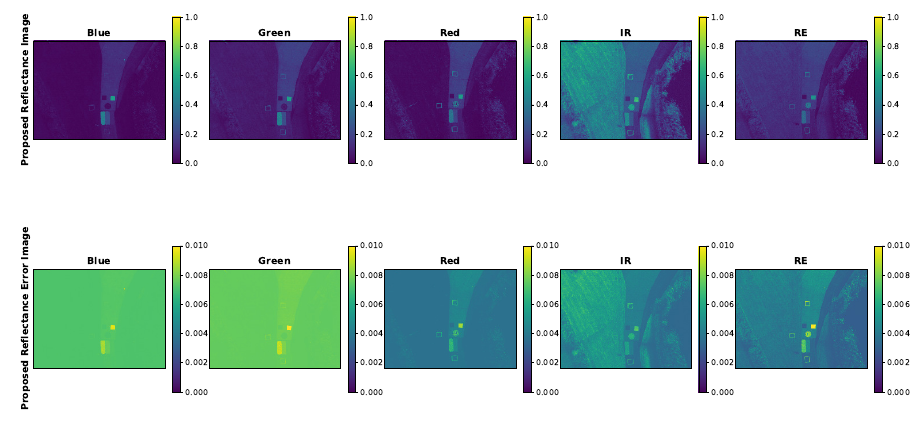
Figure 28. Example sUAS reflectance factor image and reflectance factor error image. Radiance image computed using proposed methodology and AARR used to compute reflectance factor. Reflectance factor error contains gain, exposure time, image, radiometric calibration coefficient and dls error. Error image contains same features as the reflectance factor image (concrete path, grass, demarcated targets and reflectance conversion panels). Reflectance factor is a unit-less quantity.